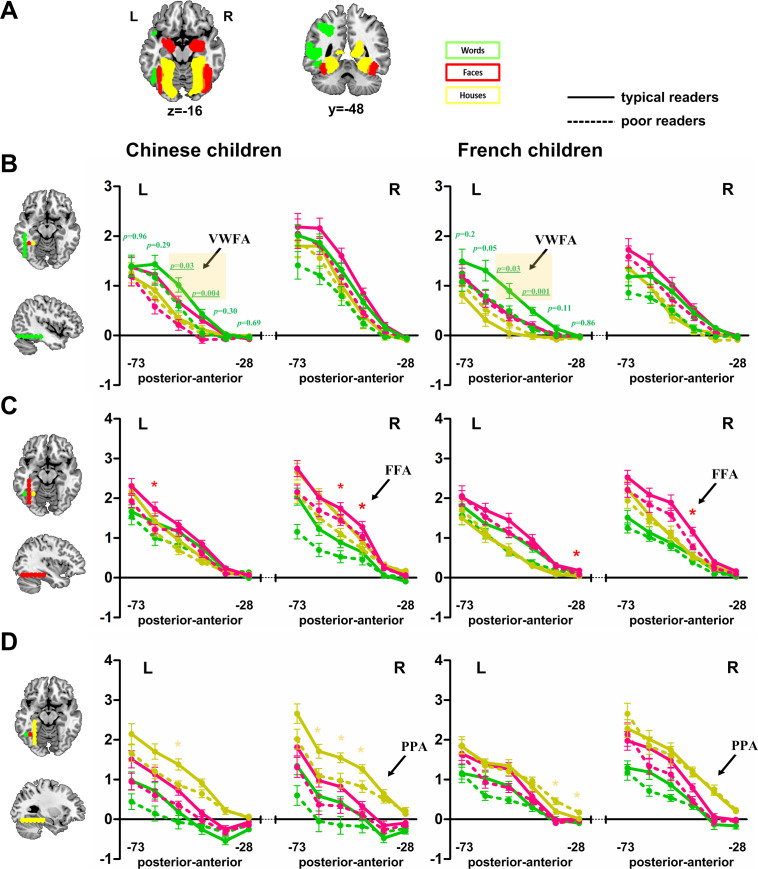
Mosaic of preferences for different visual categories (Words, Faces and Houses) in the ventral visual cortex.(A) Slices show the activation difference between a given category and the others across all participants. (B) fMRI signal change of Words relative to fixation in both Chinese and French children in successive cortical sites along the y-axis (green dots on the left cortical slices) with constant x = ±48 and z = −16. Both Chinese and French poor readers have significantly lower activations relative to their controls at a specific y site of y = −46 (pFDR_corr = 0.048 and pFDR_corr = 0.012 respectively for Chinese and French children) corresponding to the classical coordinates of the VWFA (Cohen et al., 2002). (C) fMRI signal change of Faces relative to fixation in both Chinese and French children in successive cortical sites along the y-axis (red dots on the left cortical slices) with constant x = ±39 and z = −16. (D) fMRI signal change of Houses relative to fixation in both Chinese and French children in successive cortical sites along the y-axis (yellow dots on the left cortical slices) with constant x = ±30 and z = −16. Additional files.Figure 6—source data 1.Activaions to different categories relative to fixation in ROIs in the ventral visual cortex.